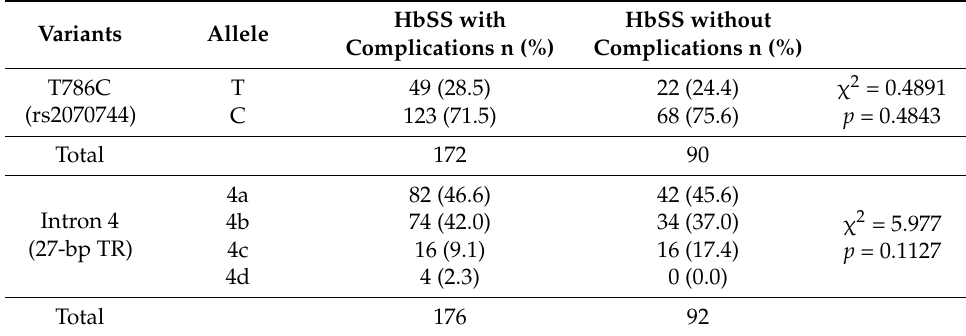
Table 2. Allele frequencies for eNOS variants in HbSS patients with complications and those without complication.